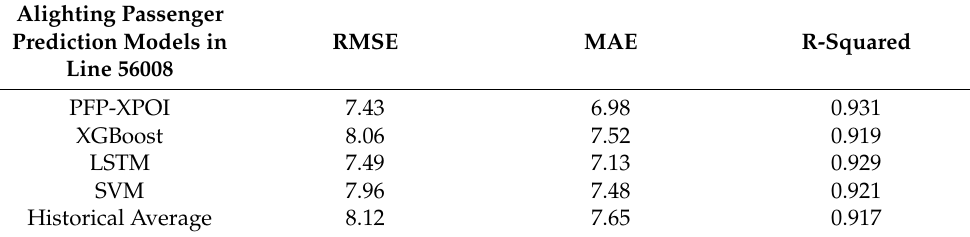
Table 3. Evaluation values of different models for alighting passenger prediction in line 56008.